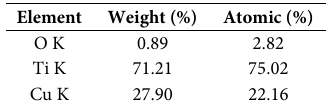
Table 3. EDAX Parameters from Figure 2 Element Weight (%)